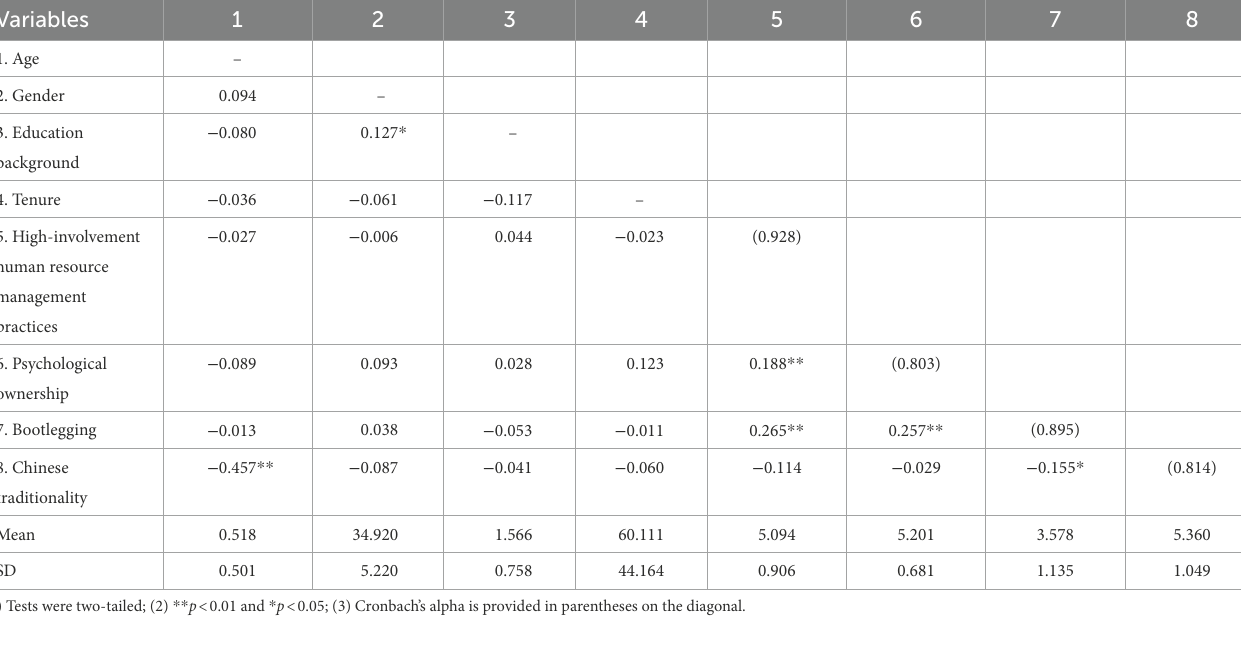
TABLE 3 Descriptive statistics and correlation ( N = 251).